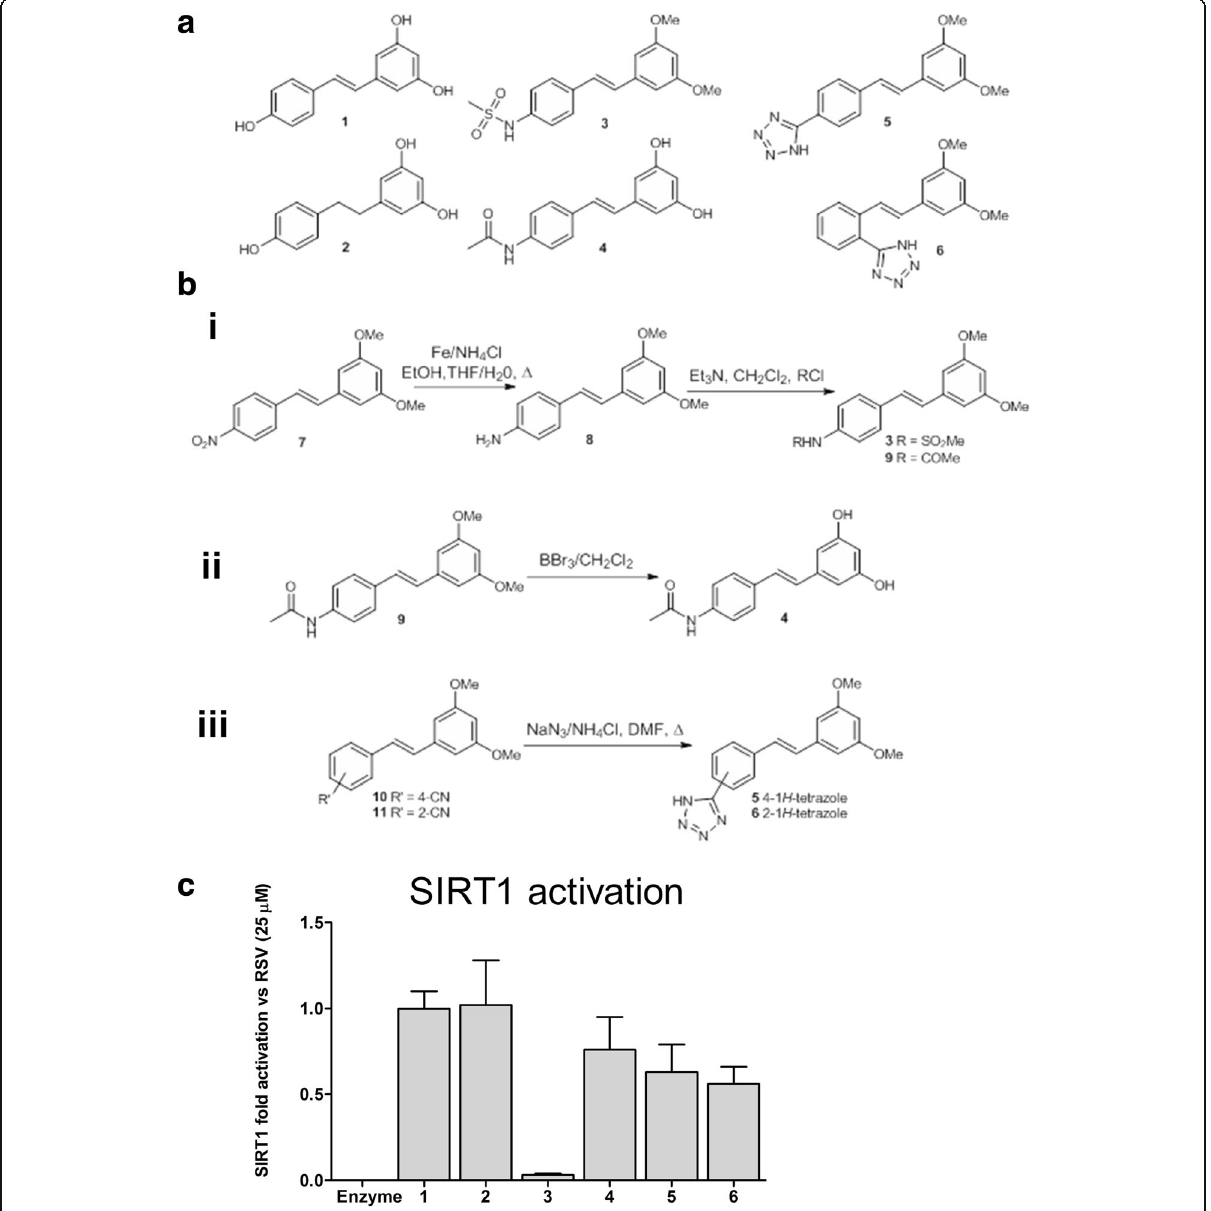
Fig. 1 Synthesis and characterisation of novel resveralogues. a Structures of resveralogues 1 – 6. Compounds are: 1 resveratrol, 2 resveratrol ’ s primary metabolite, dihydroresveratrol, 3 ( E )-N-(4-(3,5-dimethoxystyryl) phenyl)methanesulfonamide, 4 ( E )-N-(4-(3,5-dihydroxystyryl)phenyl)acetamide, 5 ( E )-5-(4- (3,5-dimethoxystyryl)phenyl)-1 H – tetrazole and 6 ( E )-5-(2-(3,5-dimethoxystyryl)phenyl)-1 H – tetrazole. b Scheme of synthesis of compounds 3 – 6